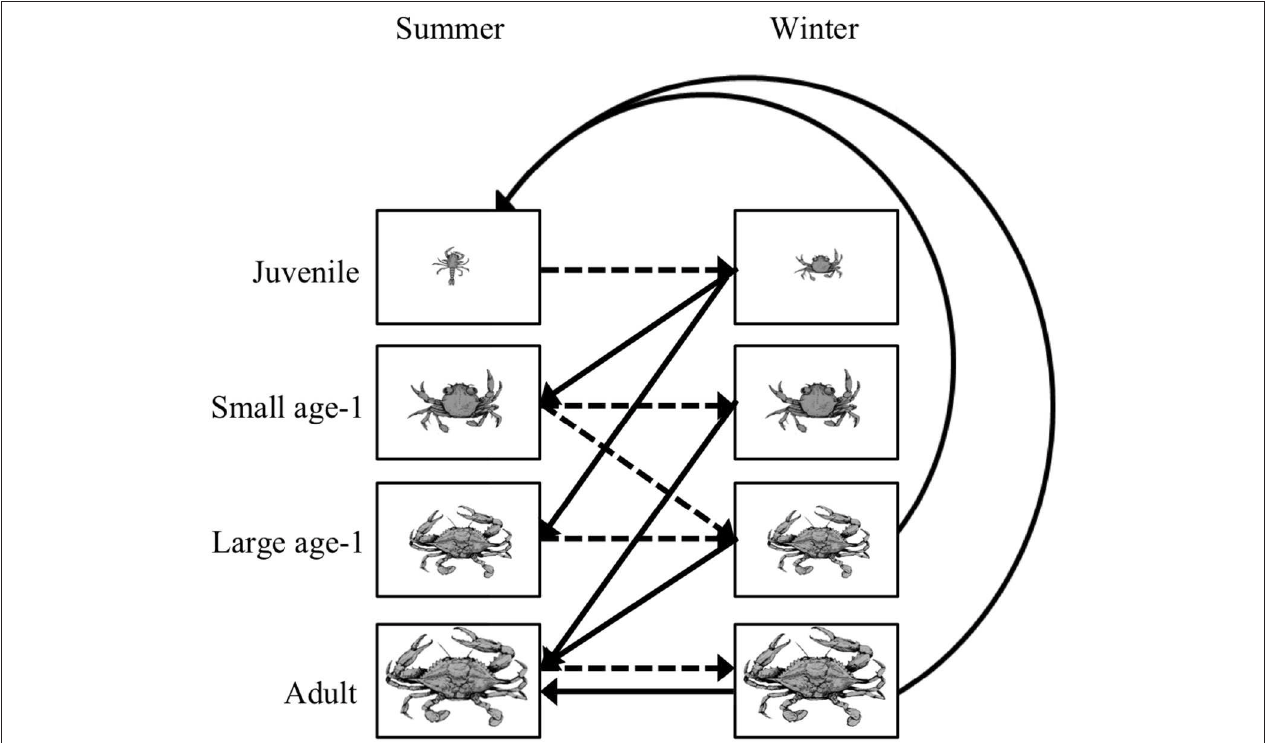
FIGURE 5 | Life cycle diagram for the blue crab Callinectes sapidus . An individual crab can be in one of four stages: juvenile, small age-1, large age-1, and adult during the summer and winter. Summer to winter transitions are represented by the dashed lines, while the winter to summer transitions are represented by the solid lines. All transitions have a 6-month time step. Note that survival and growth probabilities are straight lines, while the fecundity terms are curved lines. Figure reproduced with permission (G. Ralph, copyright holder) from Ralph